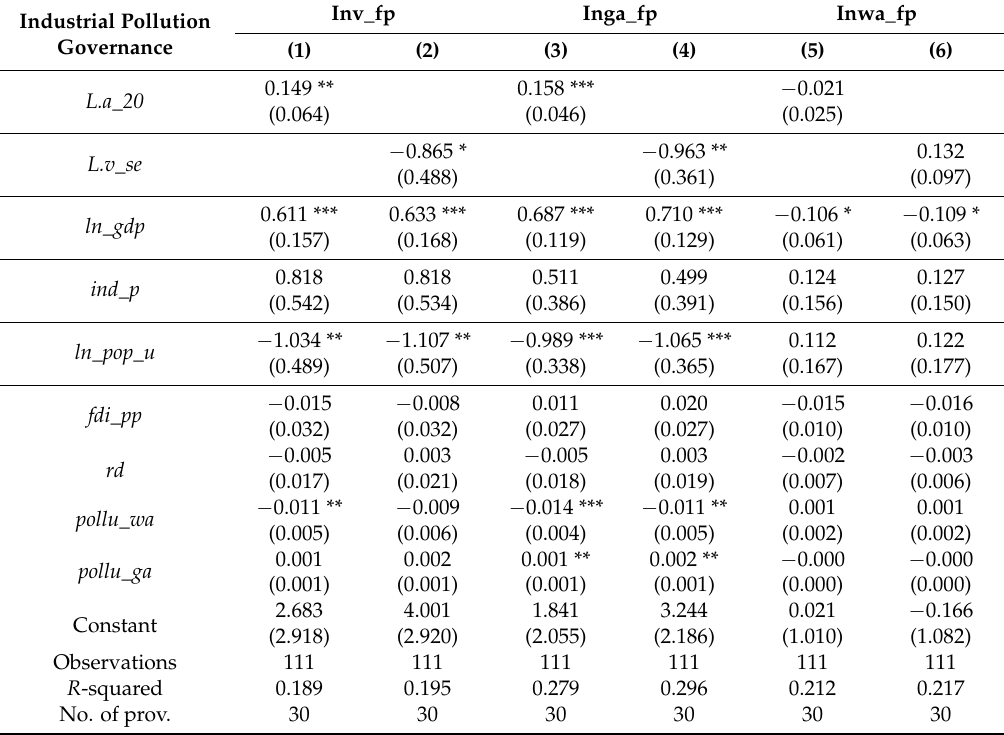
Table 8. Robustness check on the potential concerns of